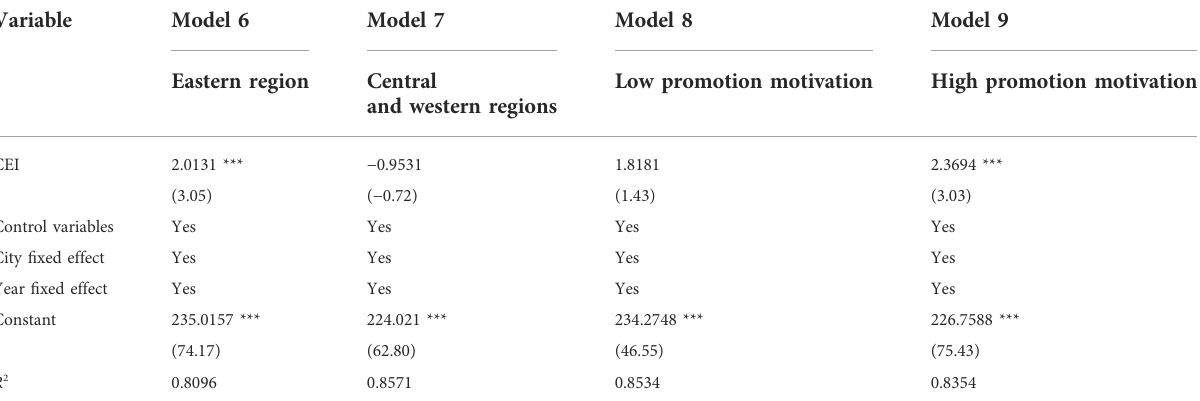
TABLE 5 Tests for